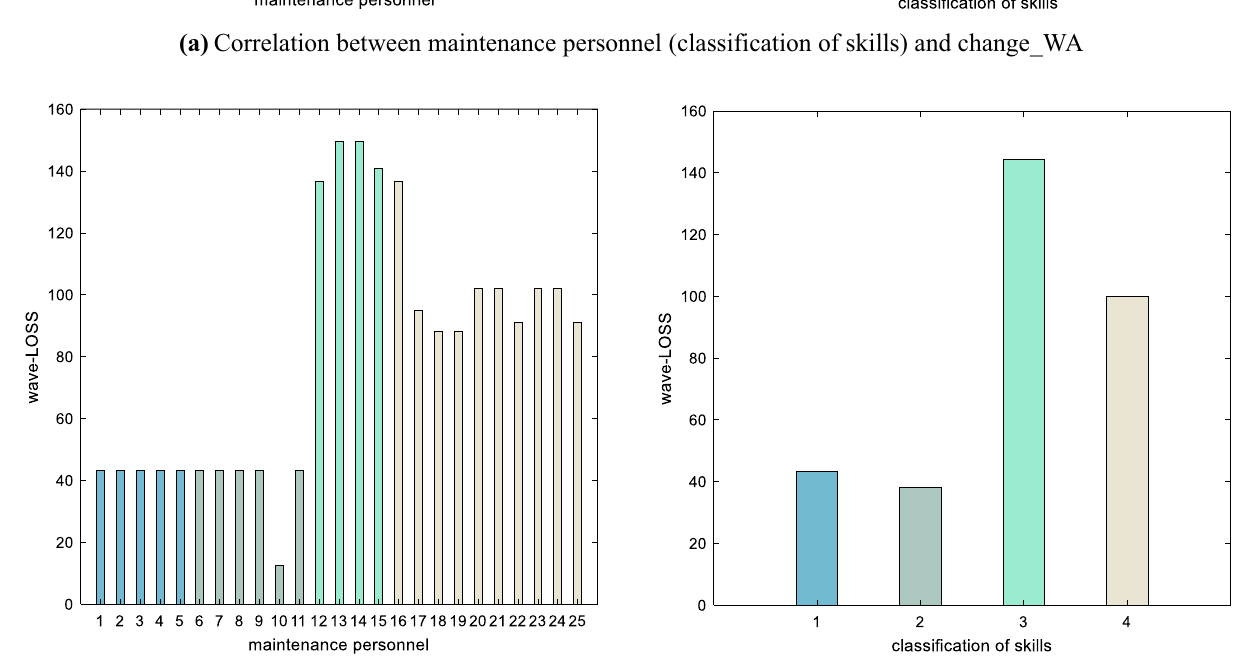
Fig. 22 Correlation between transferred maintenance personnel (classification of skills) and evaluation indexes for 13 carrier-based